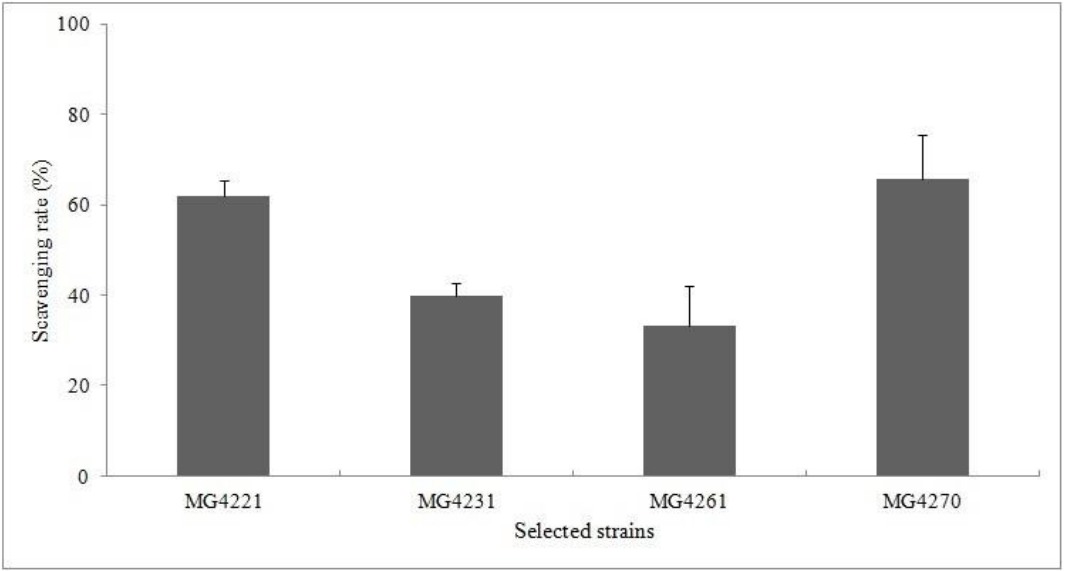
Figure 4. Scavenging rates of 2,2-Diphenyl-1-picrylhydrazyl (DPPH) radicals for selected strains.